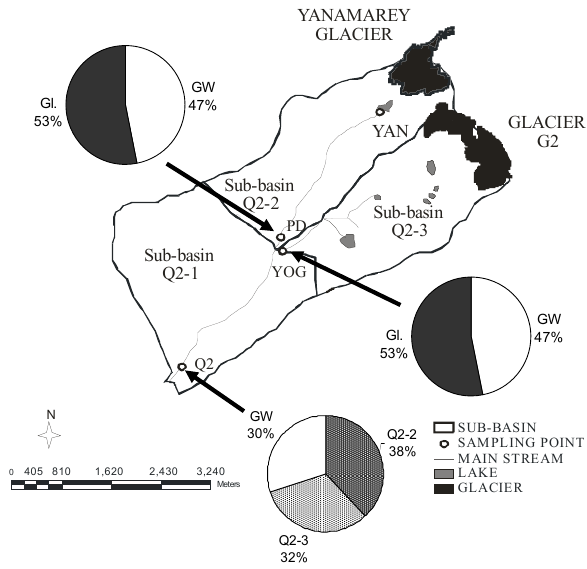
Fig. 4. 2006–2007 dry seasons end members and tributaries rela- tive contribution to surface flows of the Q2 basin. Each pie-chart related to the sub-basin map represents the average contributions at the pointed mixing point. Groundwater is represented in white and melt water in black. For the 2006–2007 dry season the over- all Q2 relative contribution is 30% from glacial melt and 70% from